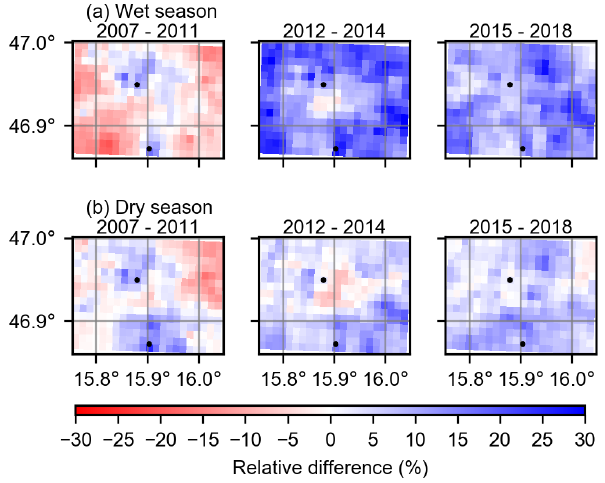
Figure 7. Mean relative difference between INCA and WegenerNet for 2007–2011 (left), 2012–2014 (center) and 2015–2018 (right) in dry (a) and wet (b) seasons. Note that only events equal to or more than 0.1mm per 15min were